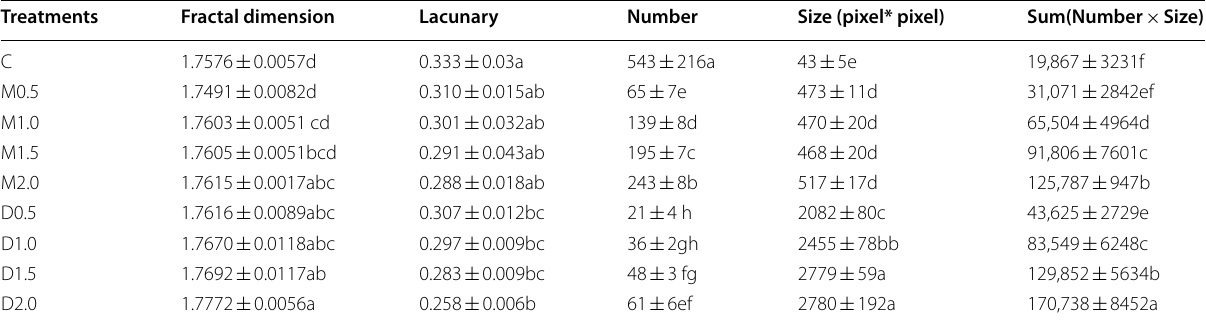
Different letters (a-f) in a column indicate significant differences (p <